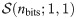
Overview of the analysis.(A) shows the distance to the odor source for each of the locations of the two 16-location grid choices (green triangles and blue dots) and the imaged area. (B) shows probability distributions of the normalized odor concentrations (normalized by source concentration). The top panel shows the composite distribution, using data of all 16 locations, for the wide grid in the fast flow condition. Below are probability distributions for two selected locations (as indicated by solid green triangles in the inset). (C) Schematic of the information-theoretic analysis. On the left is the prior probability, which is equal for all 16 locations (depicted by equal height bars). The second column shows the composite distribution (top) and the result of discretizing it into M levels (bottom). The discretization recognizes that the observer has limited coding resources available. A sample from the discretized distribution results in an updated belief of where the observer is, represented by the posterior distribution. Two example posterior distributions are shown, one for drawing the sample m1 (orange), and one for drawing the sample m2 (red). Posterior distributions have lower entropy than the prior distribution, since the locations are no longer equally likely. The difference of the entropy of the prior and the weighted average of the posterior entropy is the information a navigator can expect to learn about location with a given sampling strategy. Note that this panel is a diagram for the analysis of encoding a single sample at a single time (S(nbits;1,1)); an analogous strategy is used to analyze encoding with two sensors and/or encoding of multiple samples in time (S(nbits;rspat,rtemp)).